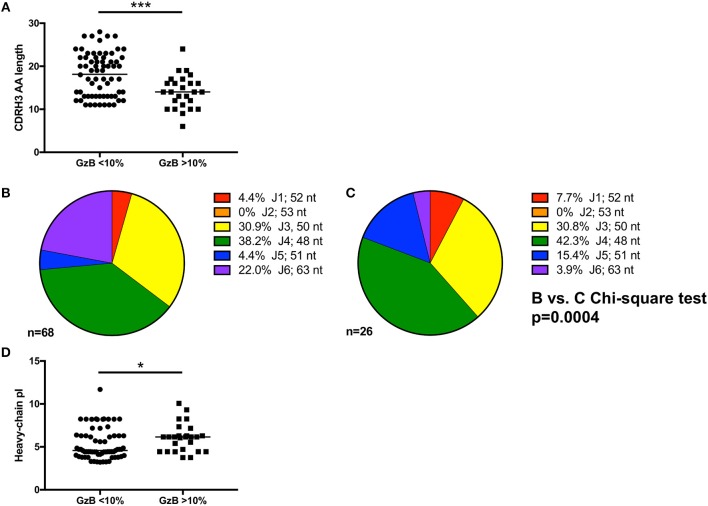
Genetic signatures of VH1-69 mAbs capable of mediating high ADCC activity. (A) Amino acid length of mAb complementarity-determining region-3 (CDRH3) (Y-axis) of mAbs with GzB <10% are longer than those from mAbs that mediate high ADCC activity (Mann–Whitney, p = 0.0007). (B) Distribution of J1 (red), J2 (orange), J3 (yellow), J4 (green), J5 (blue), and J6 (purple) utilization of VH1-69 mAbs that mediated low ADCC activity compared to (C) J-region utilization in mAbs that mediated high ADCC activity revealed differential J-region usage between the two groups of mAbs (Chi-square test, p = 0.0004). Number of sequences analyzed and percentage of each J-region utilized is indicated. (D) A modest difference in isoelectric point (Y-axis) of the heavy chain of the antibodies able to mediate high ADCC vs. low ADCC also emerged (Mann–Whitney, p = 0.035). *p ≤ 0.05, ***p ≤ 0.001.